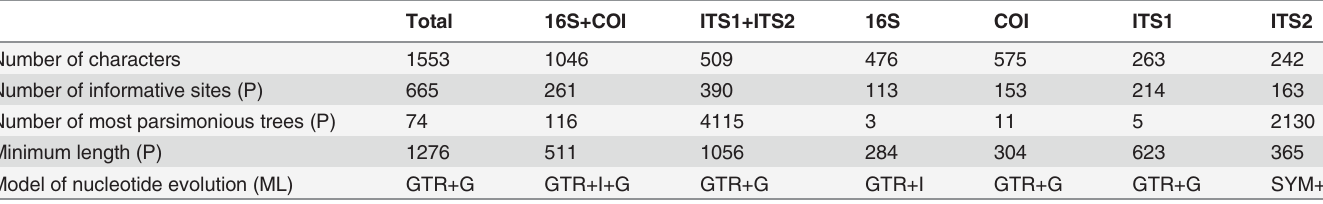
Table 4. Details of the datasets used in the phylogenetic